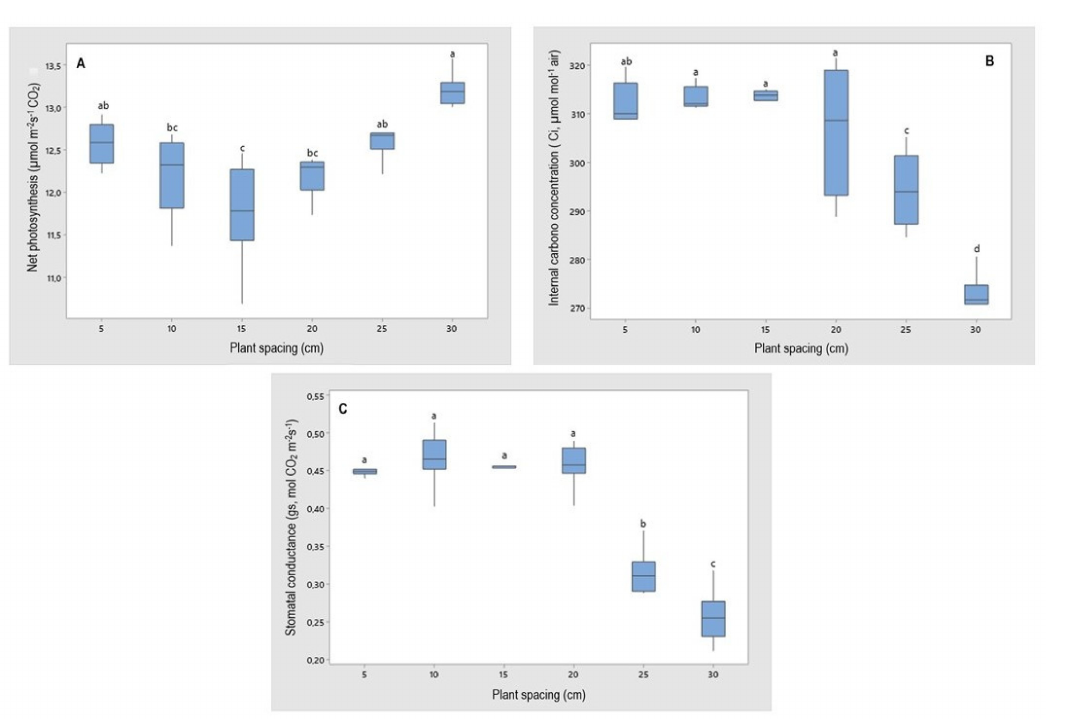
Figure 9. The response to net photosynthesis ( A ), internal carbon concentration ( B ), and stomatal conductance ( C ) of strawberry plants cv. ‘Pircinque’, in different spacing between plants with average of the 2018/2019 and 2019/2020 harvests. For each spacing, the different letters indicate significant differences ( p ≤